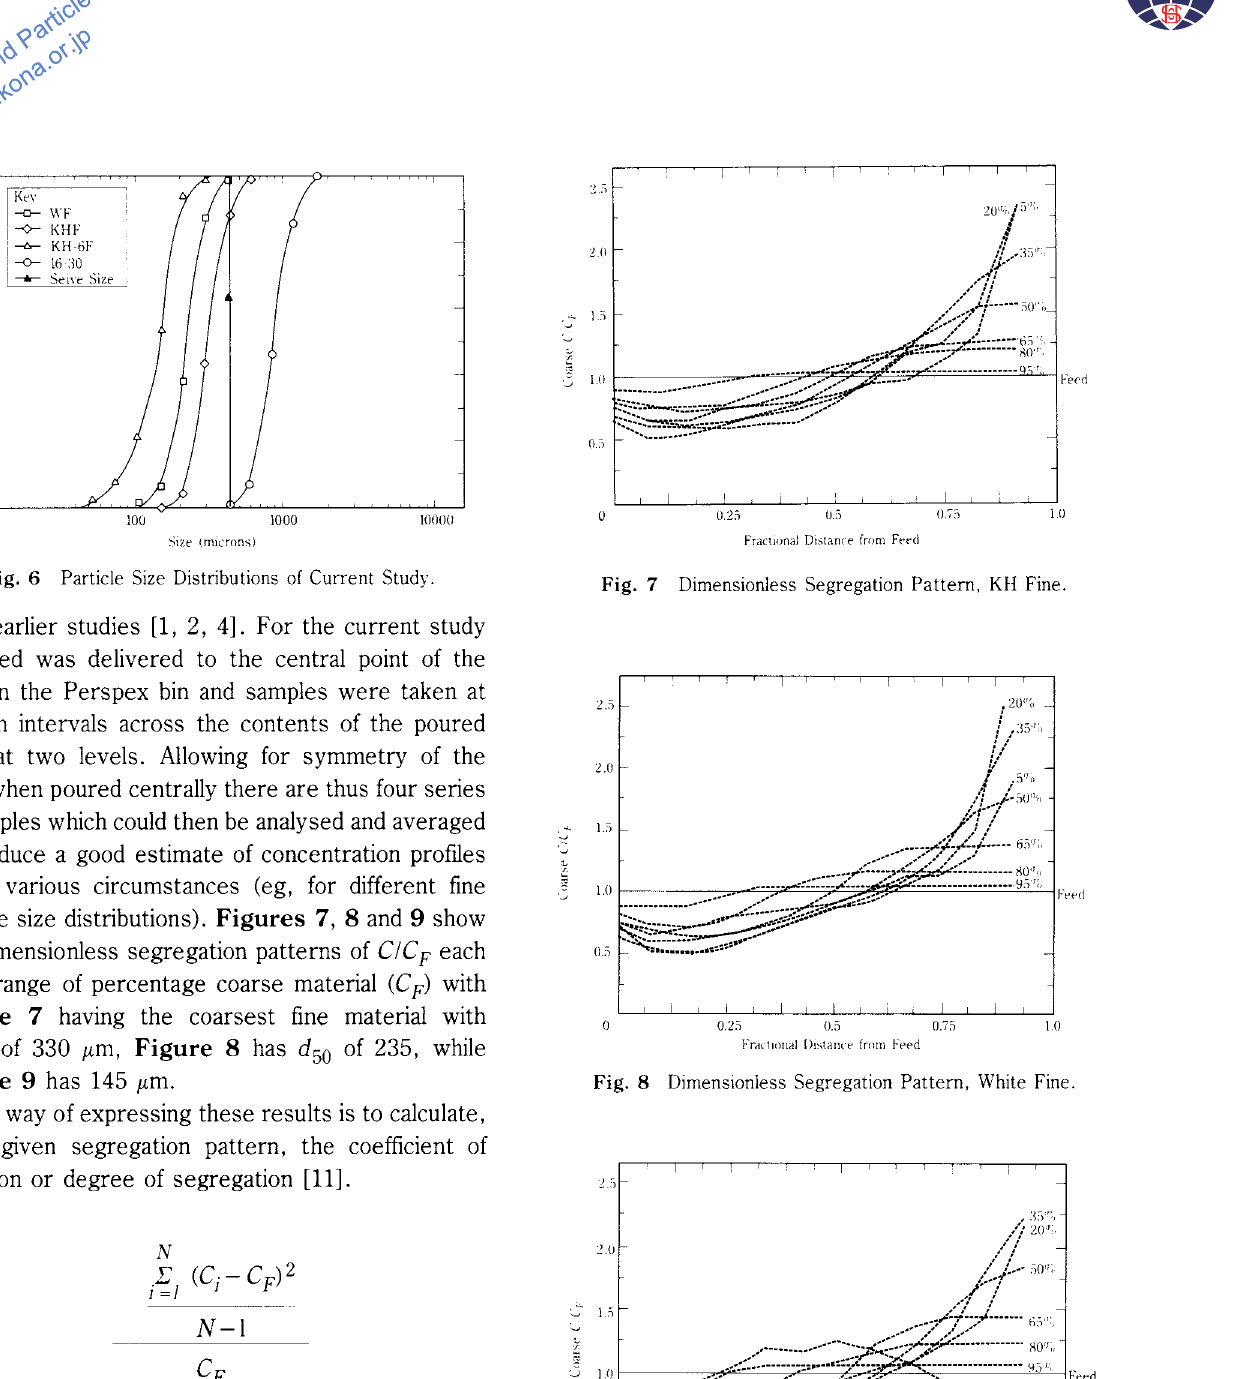
Fig. 9 Dimensionless Segregation Pattern, KH6